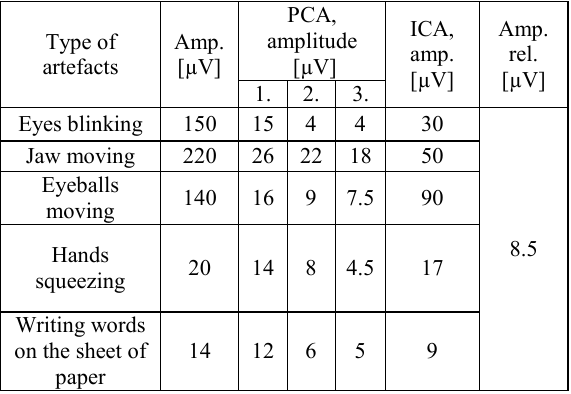
Table 1 . Mobile amplifier. Amp - amplitude of EEG signal with artefacts, Amp. rel. - amplitude of EEG signal of relaxation state.